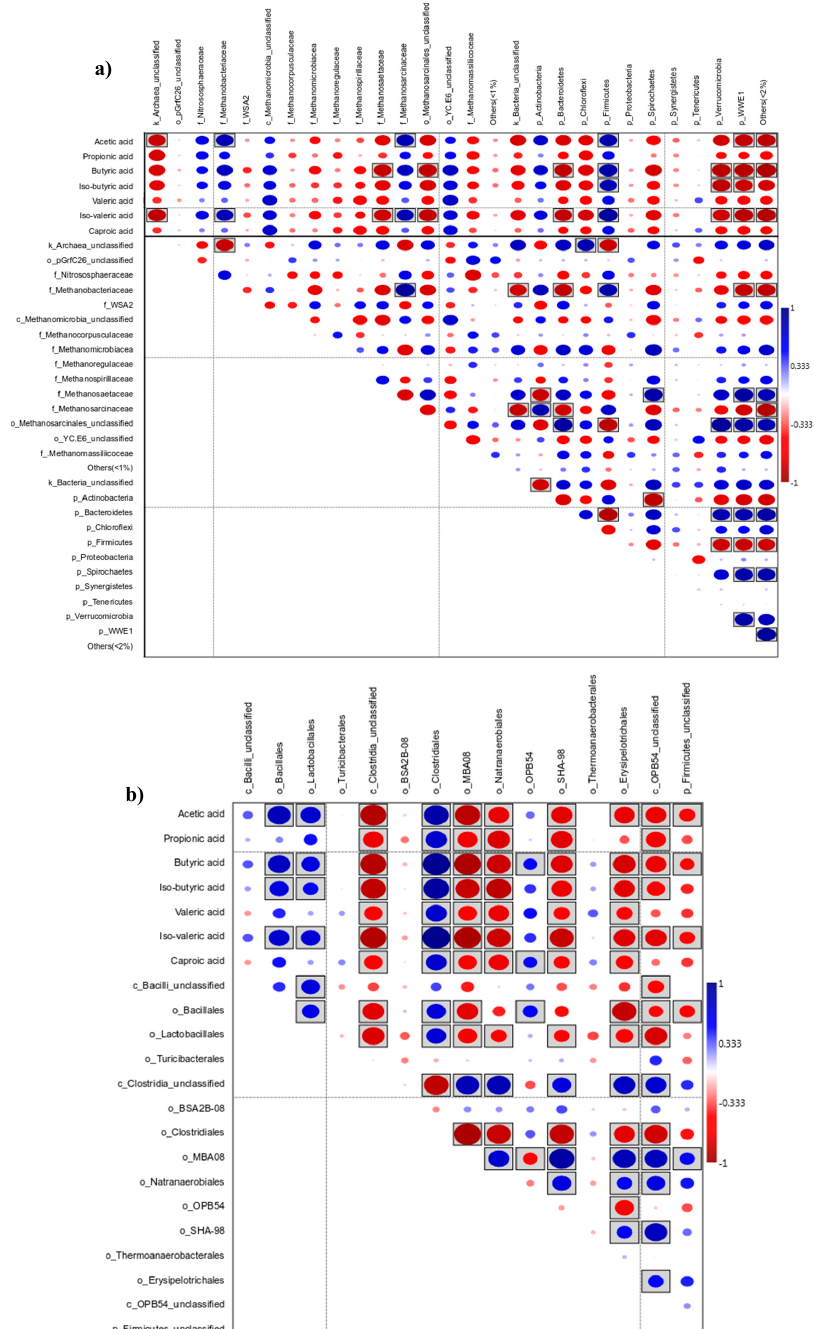
Figure 8. Spearman rank correlation between the microbial composition and the produced VFAs for the 10-day experiment, ( a ) Bacteria and archaea at family and phylum level; ( b ) bacteria at the order level (on the phylum Firmicutes), significance ( p < 0.05) labeled as boxed